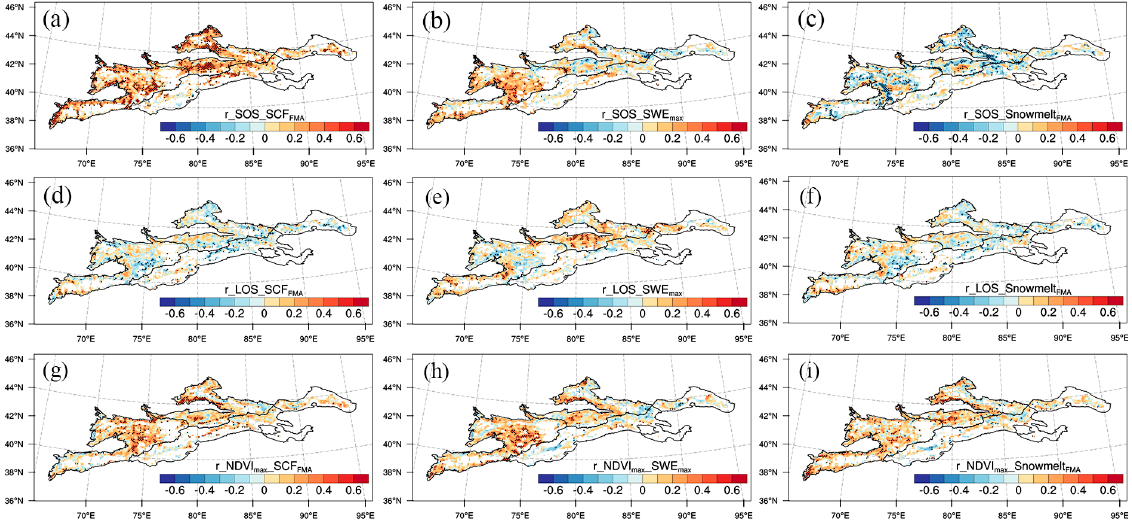
Figure 5. Spatial patterns of the correlation coefficient between vegetation metrics and SWE max (left panels), SCF FMA (middle panels), and Snowmelt FMA (right panels) from 1983 to 2015 (SOS ( a – c )), LOS ( d – f ), and NDVI max ( g – i ). The white space in Figure 5 means no data, and the black dots in Figure 5 indicate the correlation coefficient at a 0.05 significant level.